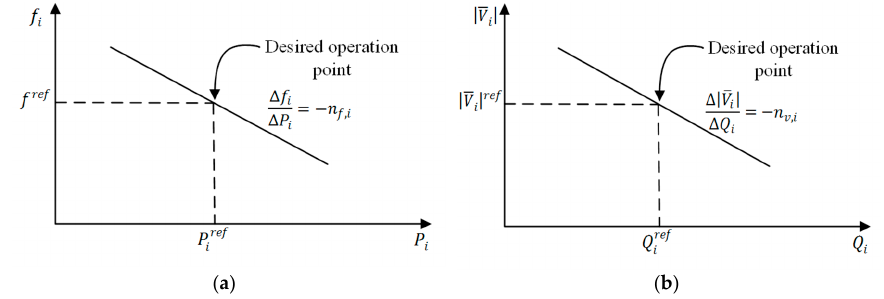
Figure 1. Droop graph for ( a ) frequency droop ( b ) voltage droop, with reference/desired operation points.